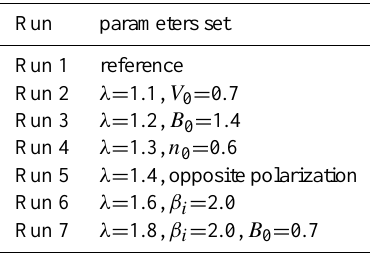
Table 1. Parameters used for different runs. λ is the initial half thickness of the discontinuity, V 0 , B 0 and n 0 the initial asymptotic value of the fluid velocity, magnetic field magnitude and density, respectively, and β i the ionic β parameter.